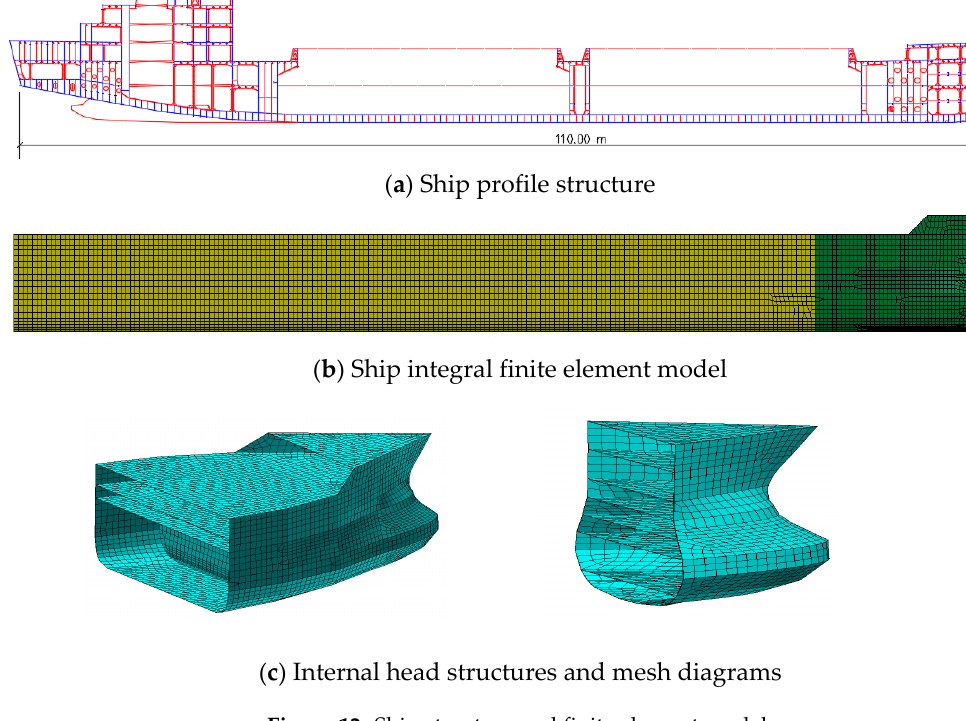
Figure 12. Ship structure and finite element model.